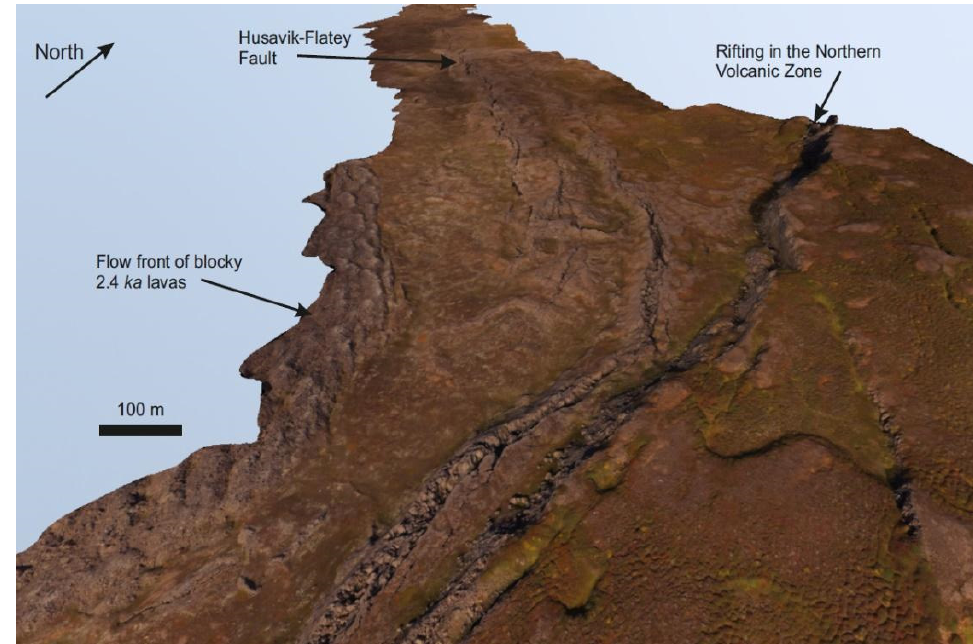
Figure 4. 3D view of the rift-transform triple junction virtual geosite; the scale is highlighted in the figure.